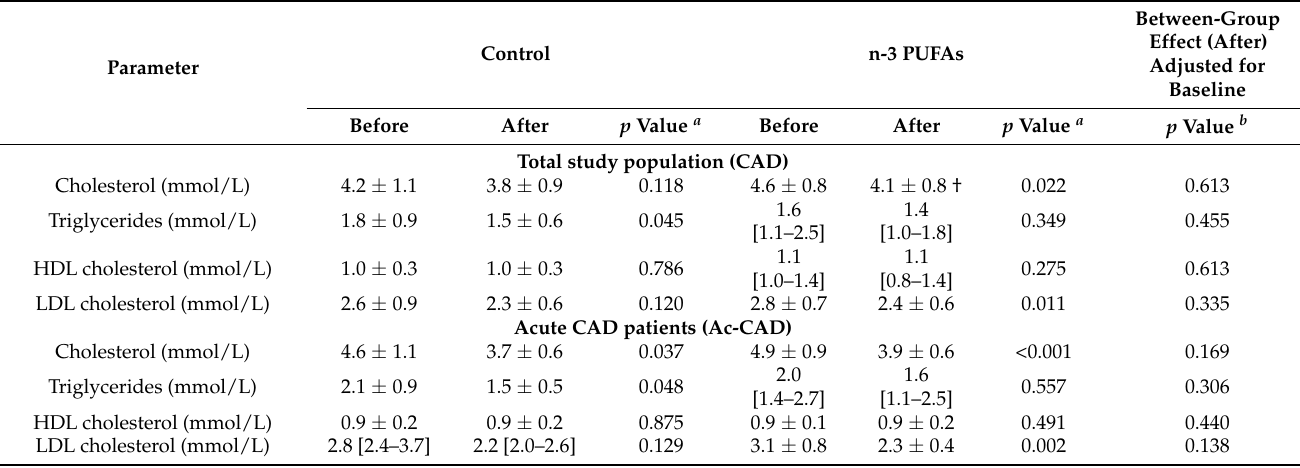
Table 4. Effect of regular (control group) and n-3 PUFA-enriched hen egg (n-3 PUFAs group) consumption on serum lipid profile in the total population (CAD) and in the two subgroups (Ac-CAD patients and Ch-CAD patients).